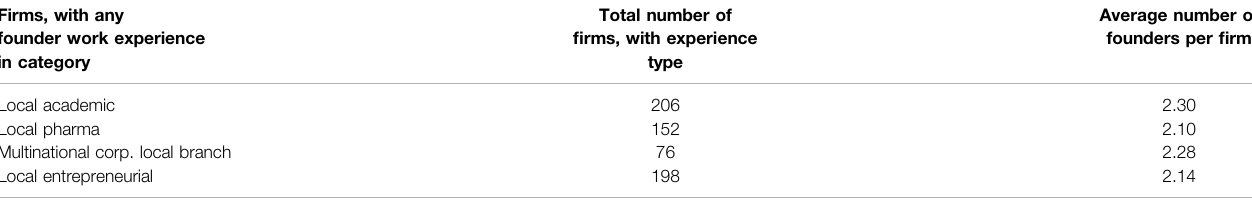
TABLE 1 | Distribution of founder local work experience